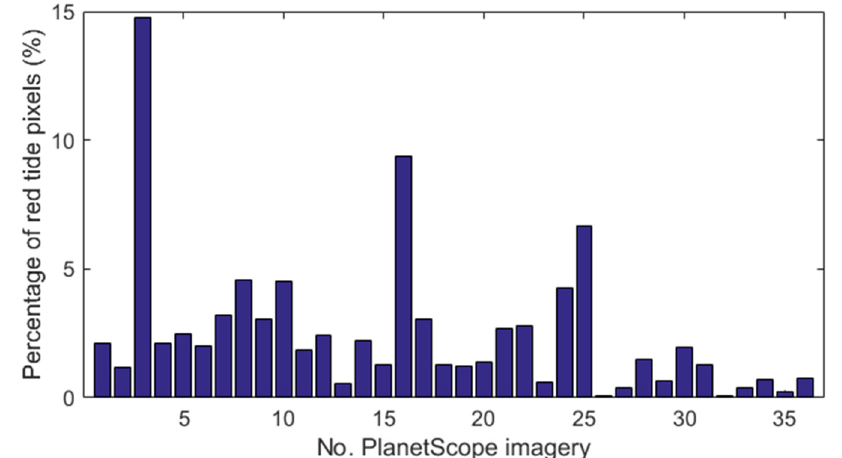
Figure 2. The percentage of red tide pixels in each PlanetScope image. U-Net was trained to classify four spectral bands of each pixel in 32 × 32 PlanetScope patches to two labels of zero and one, corresponding to non-red tide and red tide, respec- tively. Here, U-Net was constructed with five convolutional layers and five deconvolutional layers to extract spectral features related to red tide waters from the four wavelength bands of the PlanetScope images. As shown in Figure 3, the encoder block is down from the top to the bottom layers on the left to extract from coarse to fine features. The extracted features pass through the decoder block from the bottom to the upper layers on the right side. The kernel size and number of convolutional layers at the encoder and decoder blocks are summarized in Table 3. We added a dropout layer in the end of the encoder block. The softmax and output layers determine whether each pixel is related to a red tide. The loss function (L) consist of a cross-entropy ( L CE ) and L2 regularization ( L 2 ) functions with a hyper-parameter ( λ ), as defined in Equations (1) and (2) [51]. In Equation (2), t ij and y ij are the indicators and the softmax output for the i -th sample and the j -th label, respectively. N and K are the number of samples and labels, respectively.